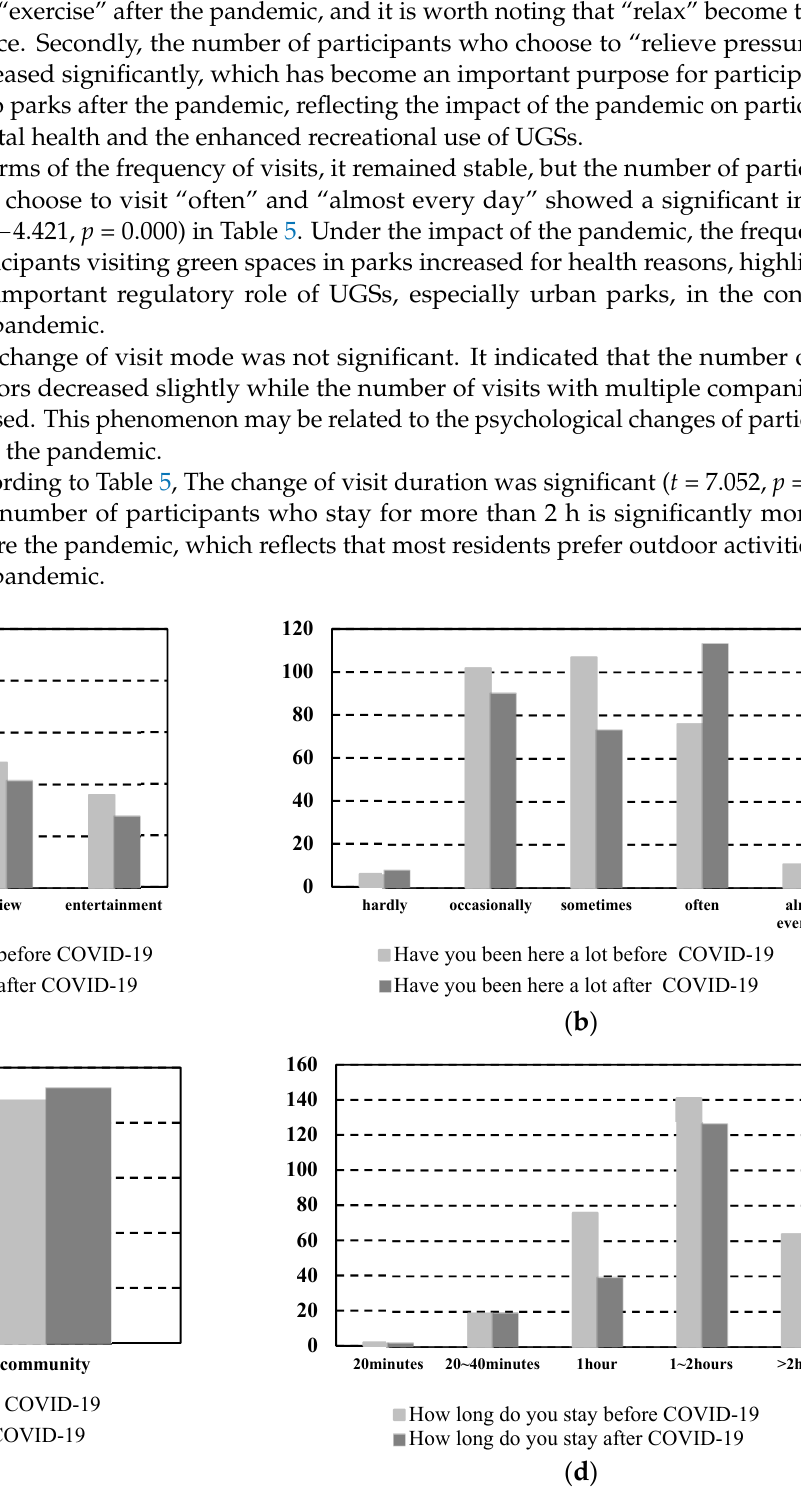
Figure 3. Urban park uses during the pandemic: ( a ) purpose, ( b ) frequency, ( c ) accompany mode, ( d ) duration. Table 5. Paired sample t -test results of visit frequency, accompany mode, and visit duration before and after the pandemic. Paired Differences t p (Before vs. Post) Before- Post-